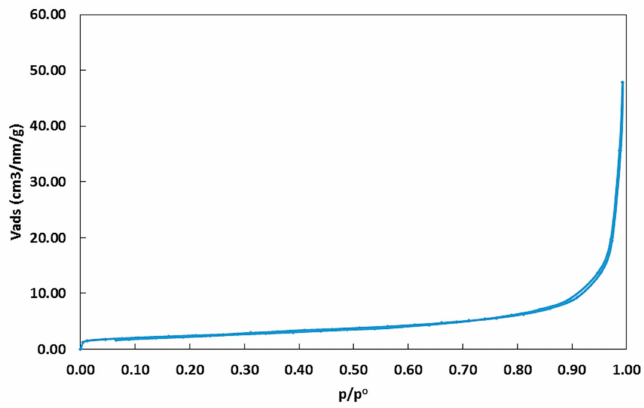
Figure 2. Nitrogen adsorption isotherm obtained for the carbon nanoparticle